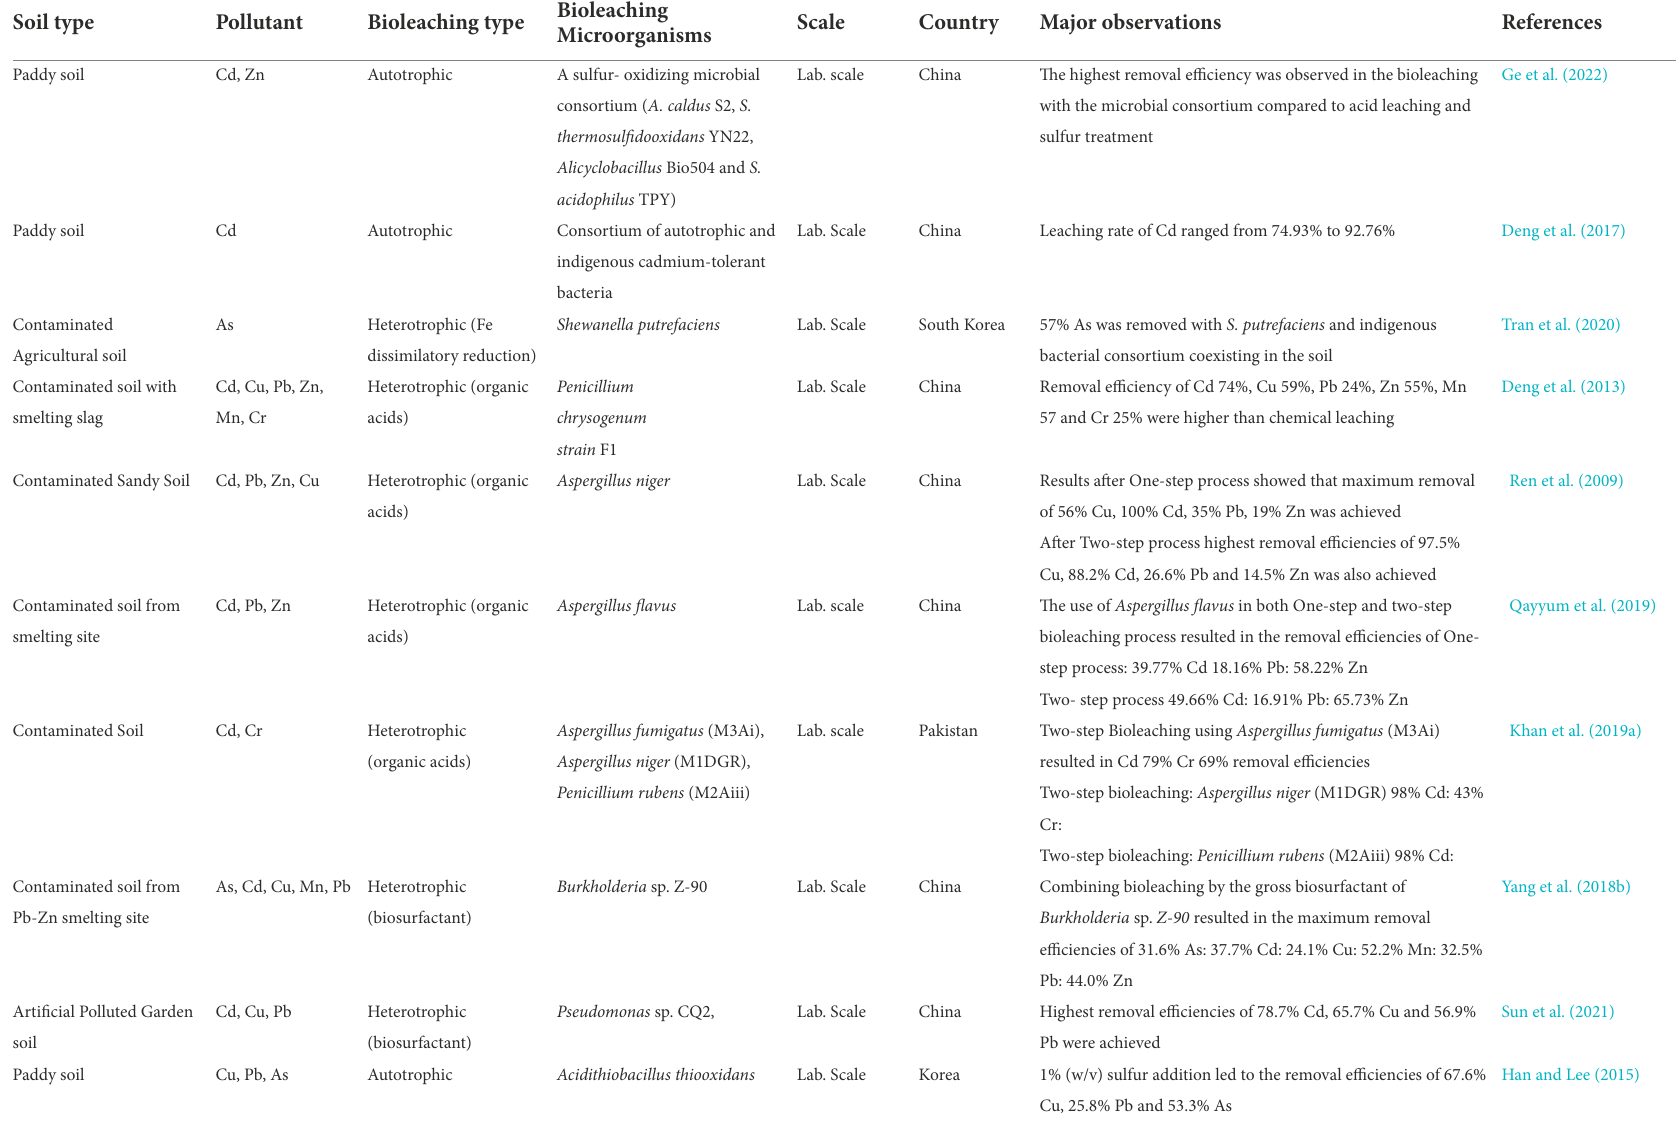
TABLE 3 The use of bioleaching for treatment of various types of toxic metal(loid)s polluted